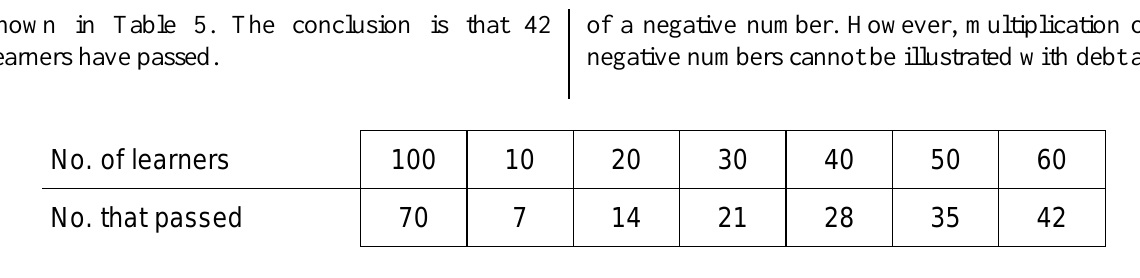
Table 5. A ratio table of learner performance